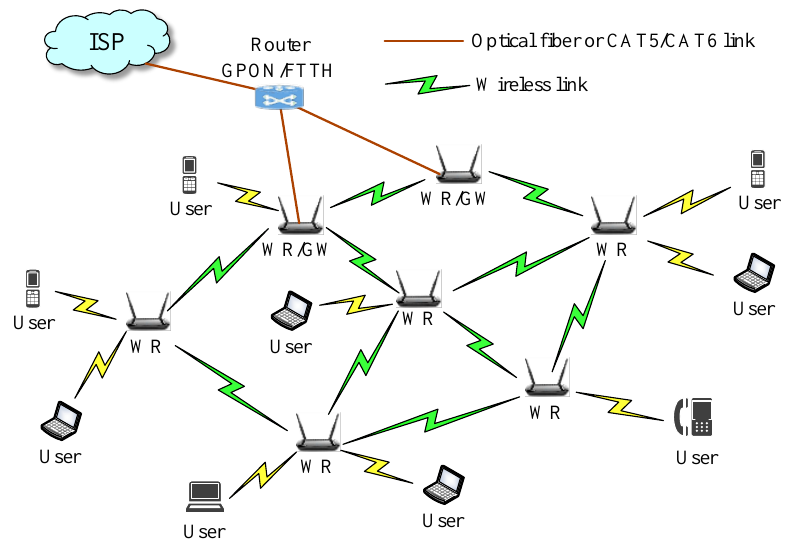
Figure 1. The general architecture of the WMN